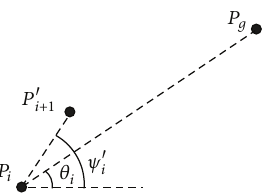
Figure 3: Schematic diagram of approaching target.